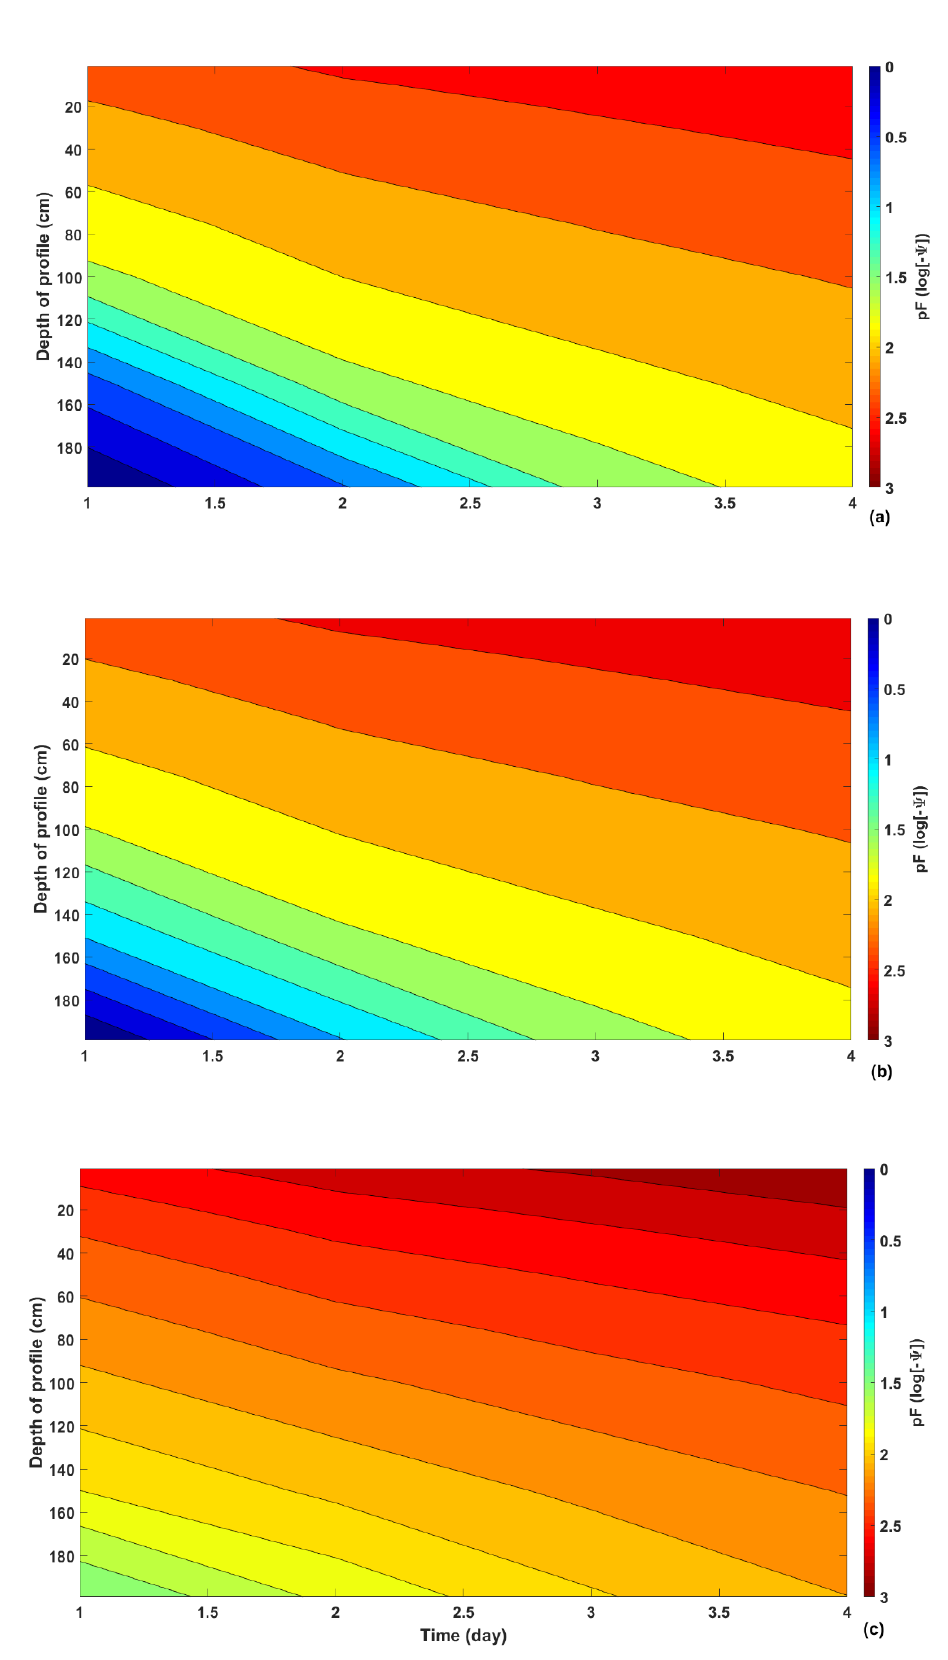
Figure 5. The simulated water potentials of the bauxite residue in a storage facility with initial water potentials of ( a ) − 1 kPa, ( b ) − 2 kPa and ( c ) − 10 kPa when exposed to a small rainfall event (1.7 mm). Ψ: water potential (hPa).